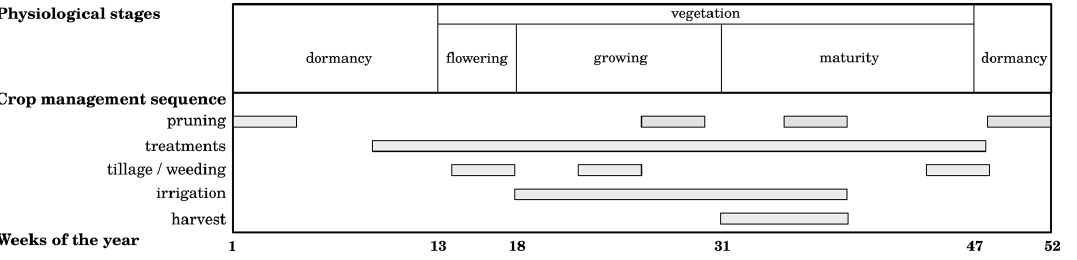
Figure 6. Distribution of the physiological stages and crop management sequence of apple crop over the weeks of a year selected for the national